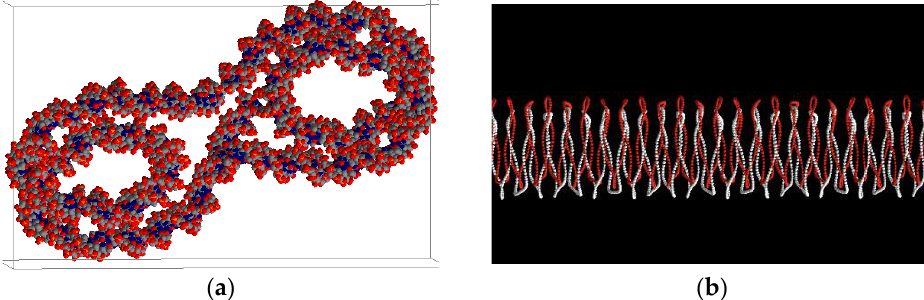
Figure 1. ( a ) Visualization of the realistic PDB4DNA DNA model on the default application pro- gramming interface, OpenGL. ( b ) Visualization of the original DNA model used in previous work [22] on OpenGL.